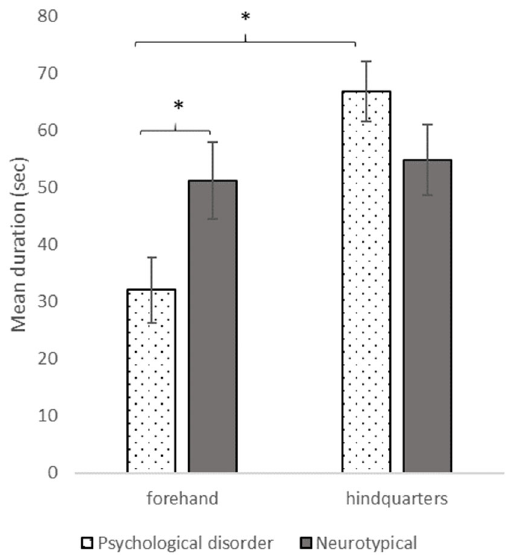
Figure 3. Mean duration (in seconds) of brushing different horses’ body area between participant with psychological disorder (N = 17) and without (N = 29). Mann ‐ Whitney and Wilcoxon tests, * p < 0.05. * p <